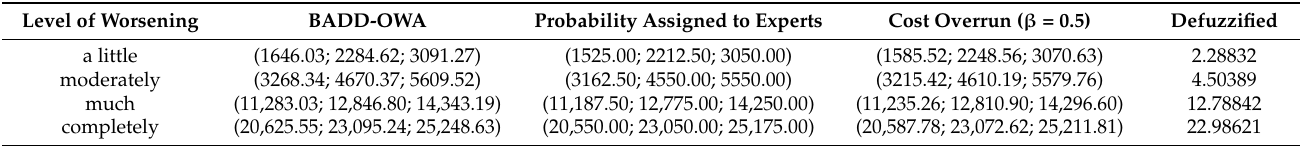
Table 8. Summary of cost overrun per patient by level of worsening of initial pathologies.